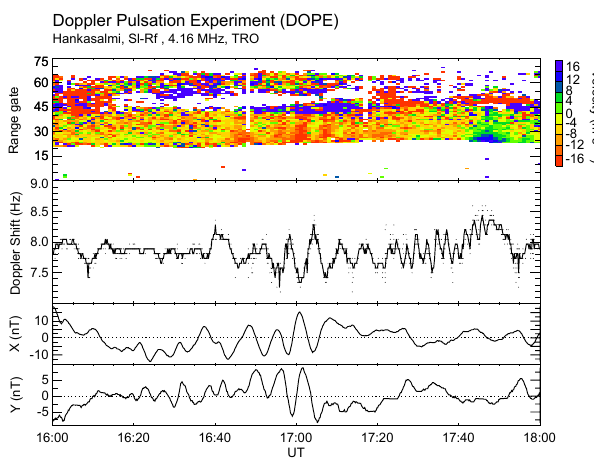
Fig. 1. Top to bottom: SuperDARN Doppler velocity as a function of range and time (Hankasalmi, beam 5); Doppler shift at 4.16MHz versus time, measured by DOPE; X and Y components of the mag- netic field perturbations measured at Tromsø for 16:00–18:00 UT, 25 March 2002.